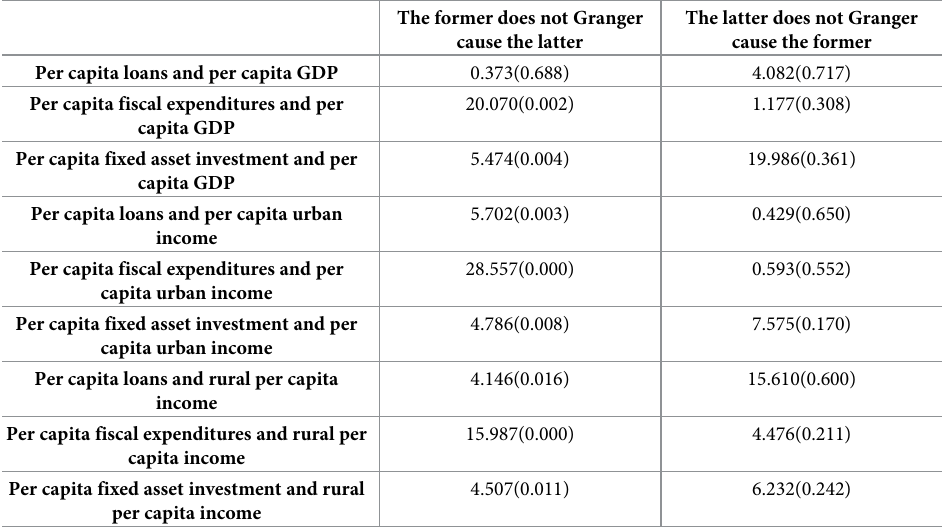
The former does not Granger The latter does not Granger cause the latter cause the former